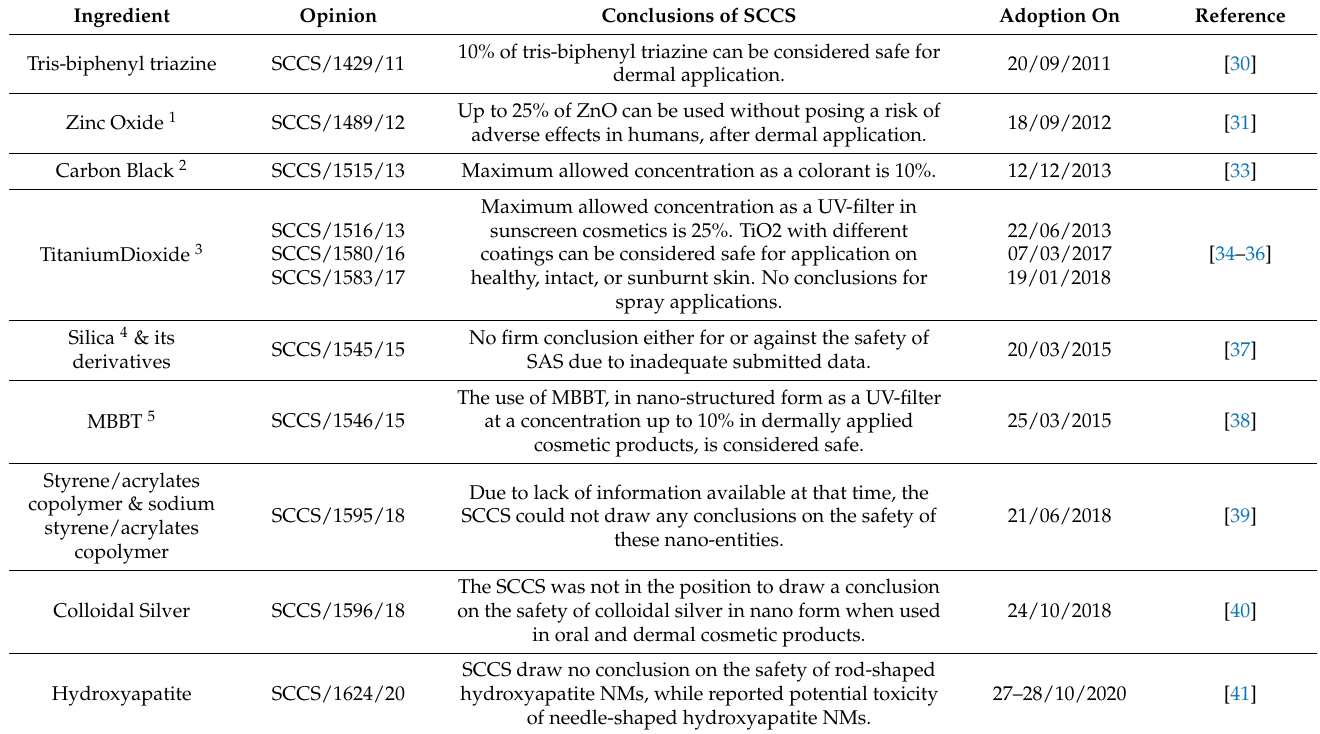
Table 6. Conclusions of the SCCS on opinions published for